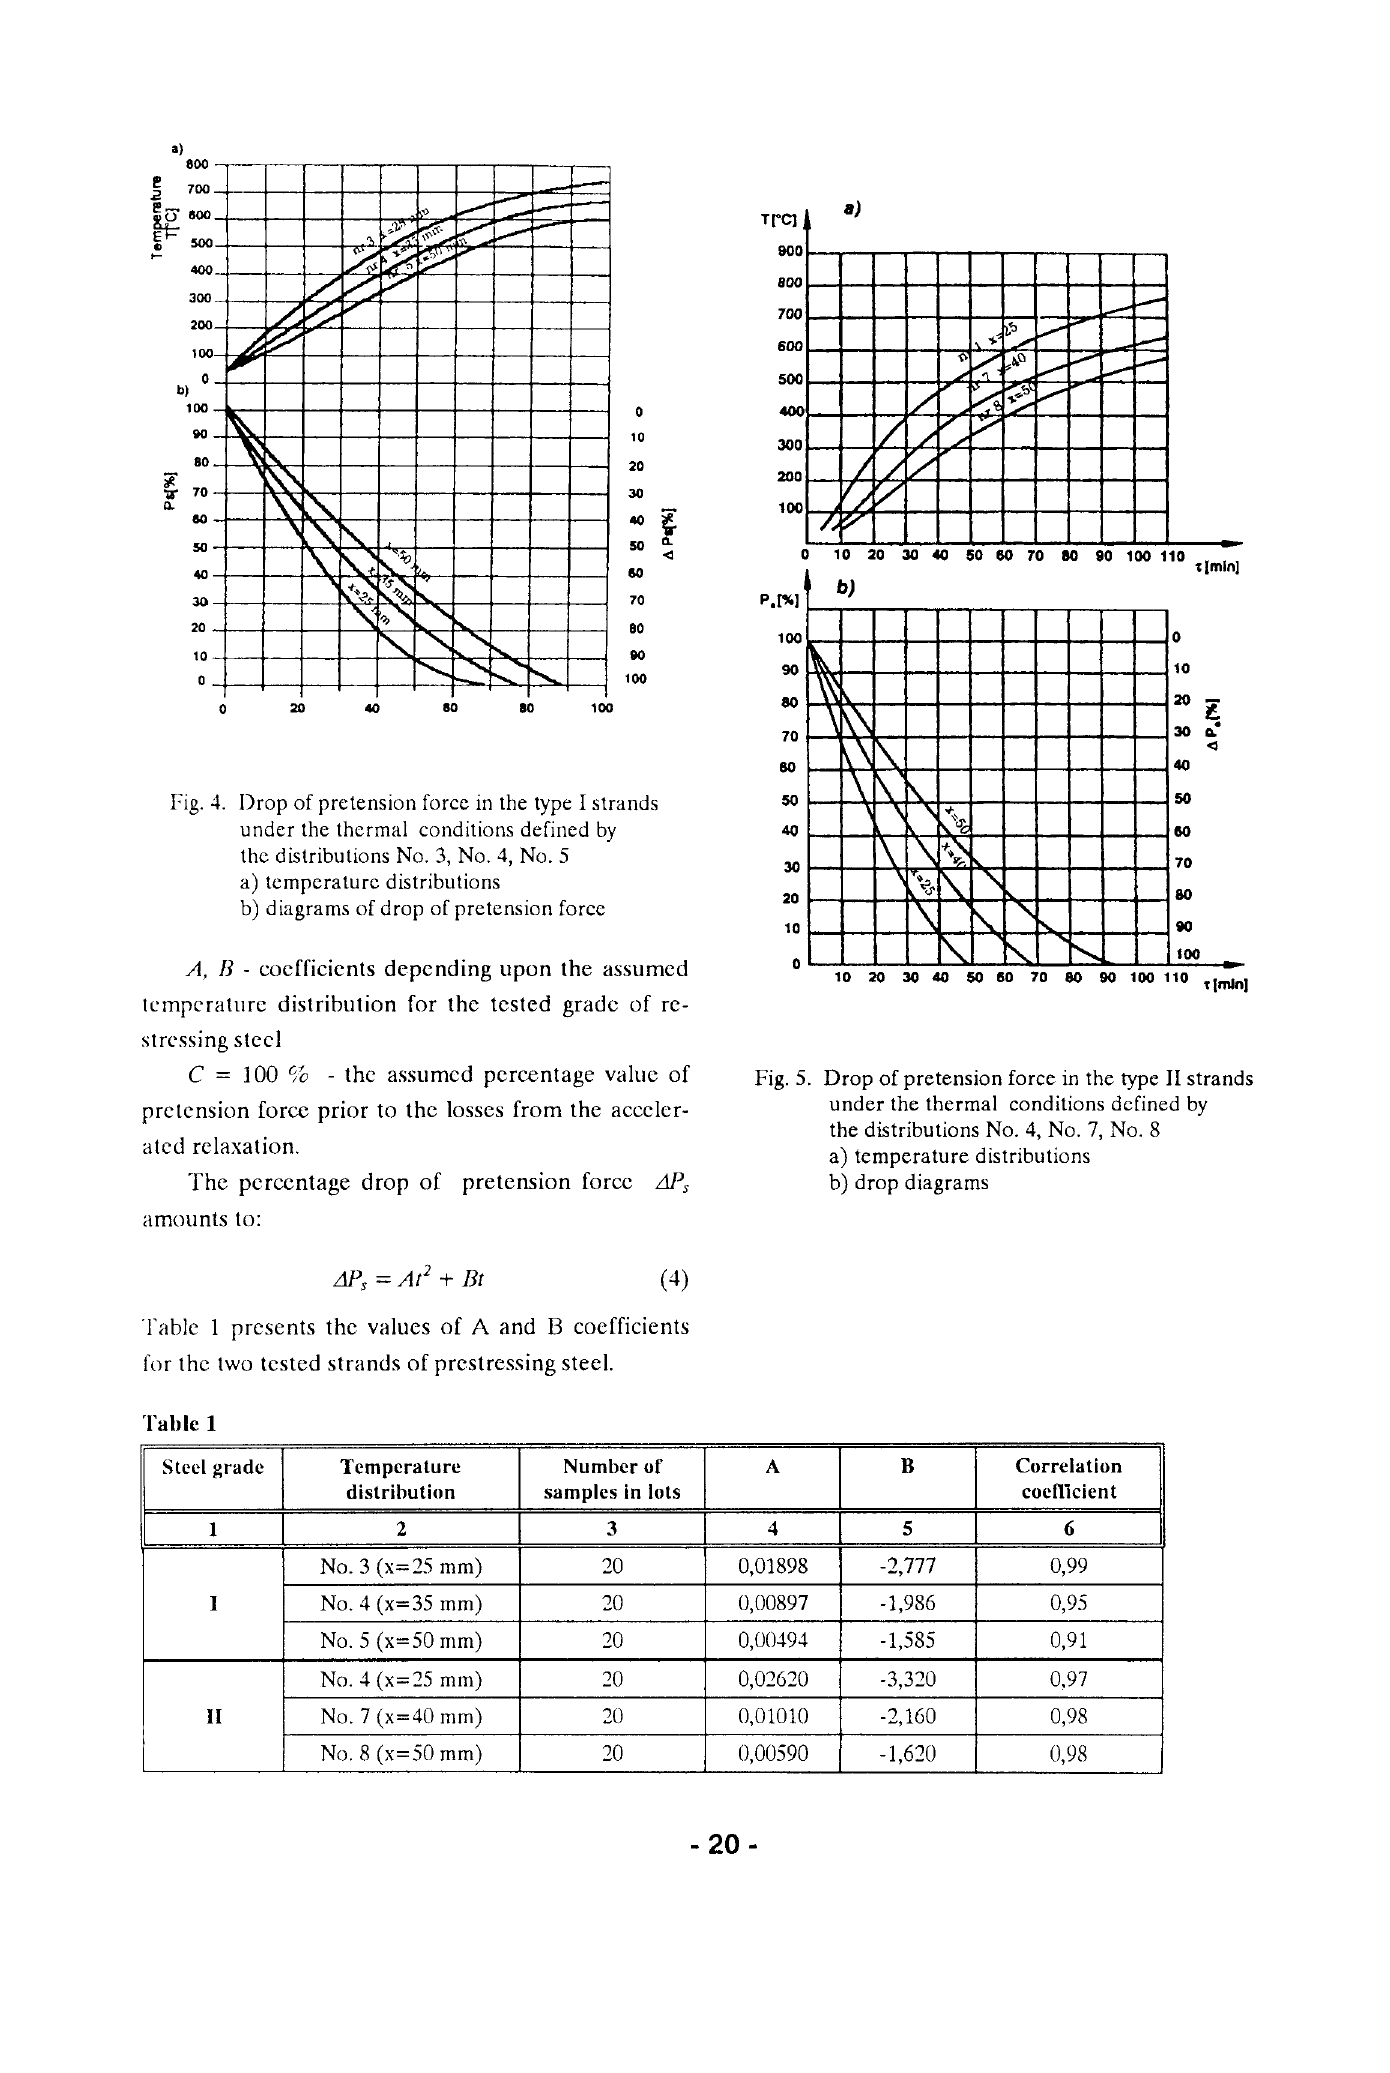
Fig. 4. Drop of pretension force in the type I strands under the thermal conditions defined by the distributions No. 3, No.4, No.5